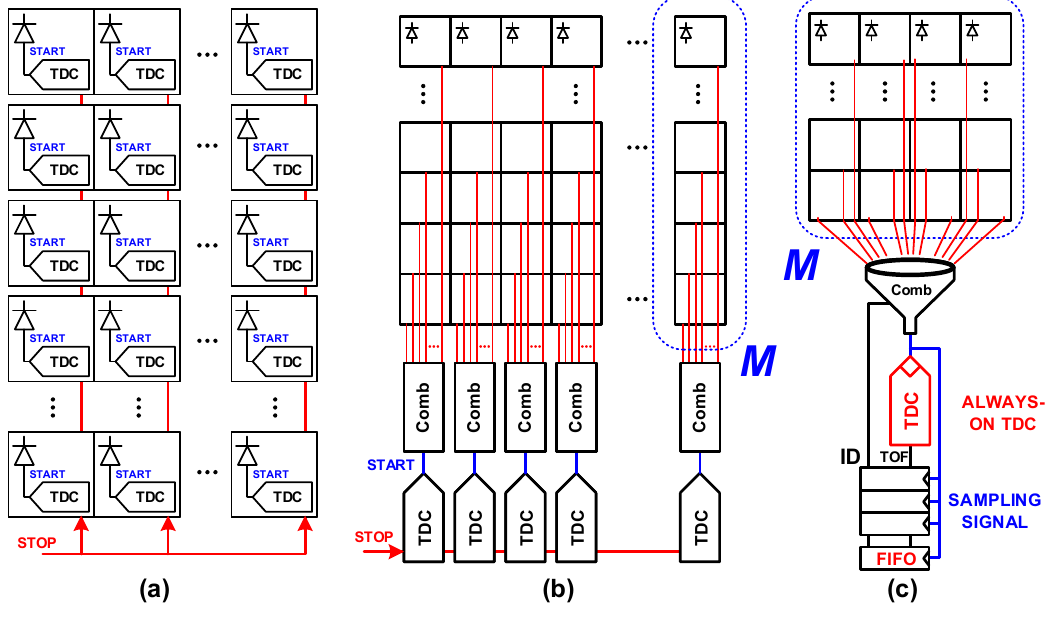
Figure 2. TDC arrangement. ( a ) Per-pixel, event-driven TDC; ( b ) Column-wise shared TDC; ( c ) Continuously running, shared TDC concept. FIFO: first-in-first-out; TOF: